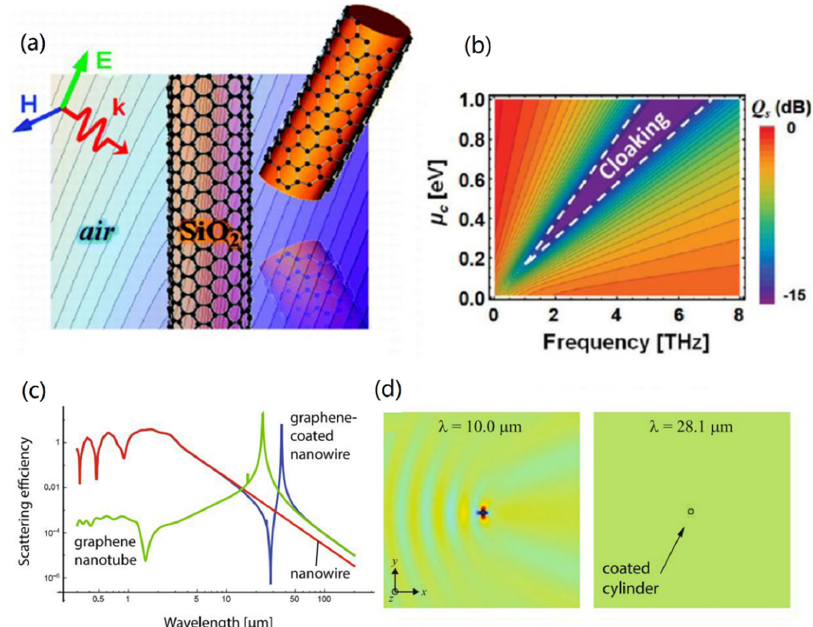
Figure 12. ( a ) Graphene-coated cylindrical object. ( b ) Scattering gain (Q s ) for the graphene cloak varying chemical potential and the frequency of operation with τ = 0.5 ps. Reprinted with permission from reference [126]. Copyright American Chemical Society, 2011. ( c ) Scattering efficiencies (Q sca ) of three structures. ( d ) Normalized electric field |E/E 0 | for a GCNW with R = 0.5 μ m illuminated by a transverse-electric (TE)-polarized plane wave at λ 0 = 10.0 μ m and 28.1 μ m, corresponding to the invisibility window in ( c ). Reprinted with permission from reference [127]. Copyright Springer Nature, 2017.